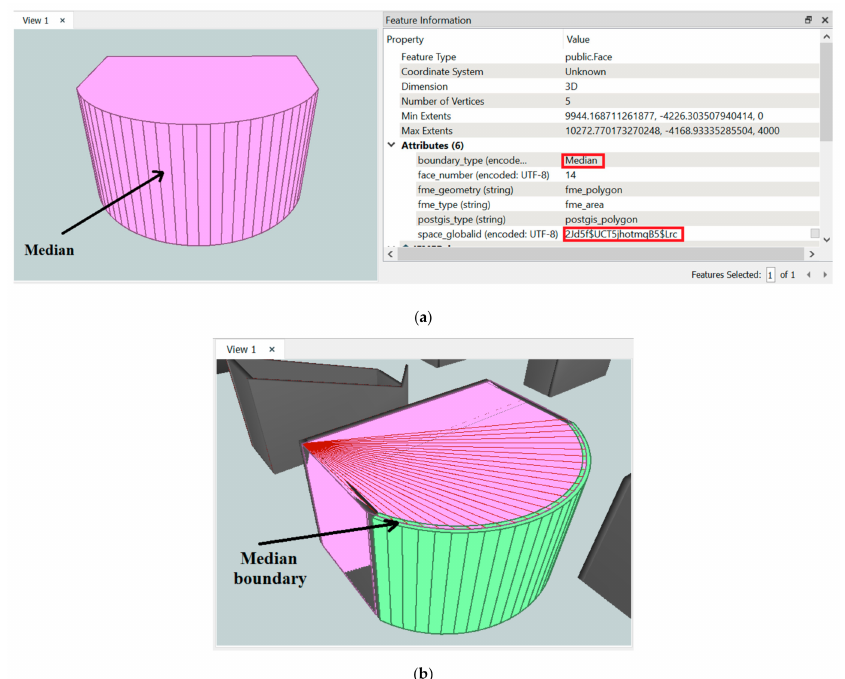
Figure 28. The Median boundary type has been assigned to the face of a legal space with a curved wall, ( a ) faces of legal space itself, ( b ) faces of legal space with surrounding